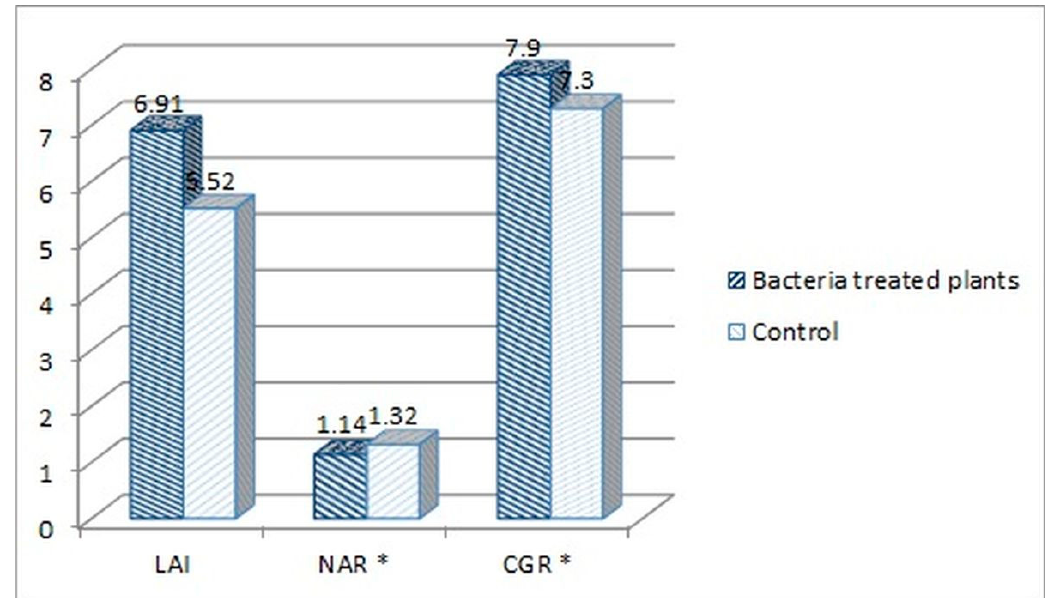
Figure 5. Comparison of the plant growth indexes of the consortium-treated tomato plants and water-treated control group. Calculated indexes: leaf area index (LAI), netto assimilation rate (NAR), and crop growth ratio (CGR) (* The NAR and CGR original values were multiplied both by 100, for better visualization on the chart).